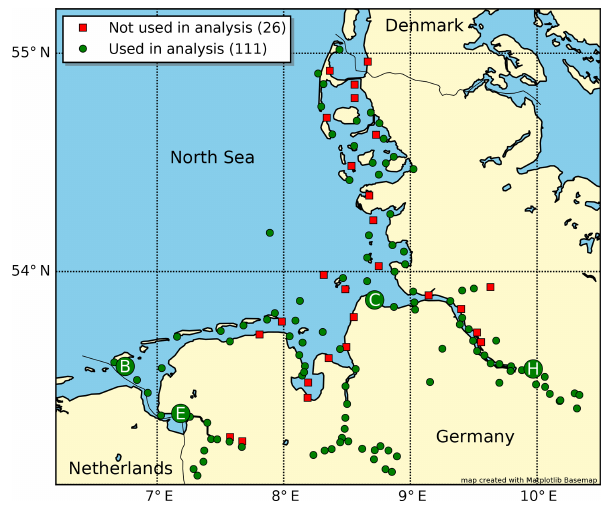
Figure 1. The locations of all tide gauges in the German Bight from Table A1. Some of the tide gauges mentioned in the text are high- lighted: Borkum, Fischerbalje (B); Emden, Große Seeschleuse (E); Cuxhaven, Steubenhöft (C); and Hamburg, St. Pauli